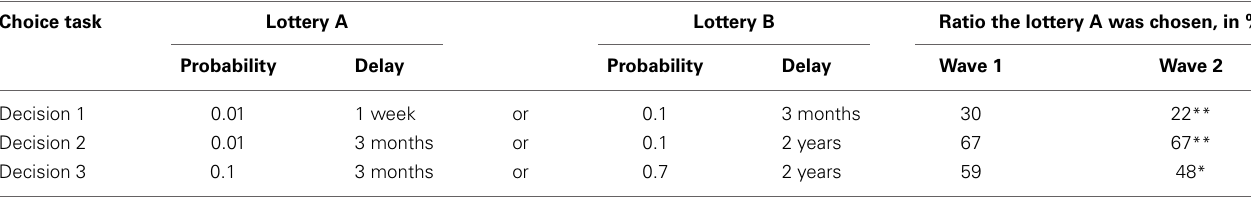
Table 1 | Choice Tasks in study 1.